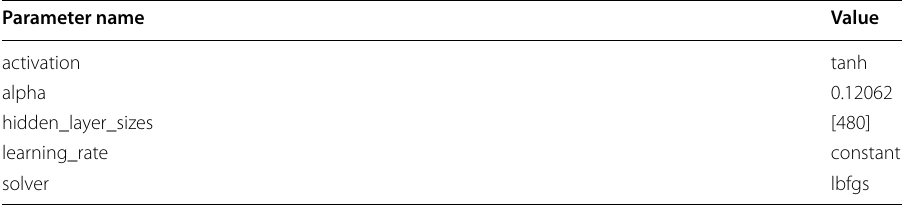
Table 66 Modes of MLP tuned hyperparameter values for experiments with the information theft dataset